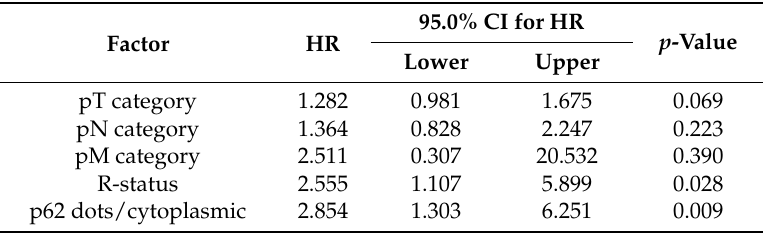
Table 1. Results of multivariate analysis including pT, pN, and M category. Table 2. Results of multivariate analysis including UICC/AJCC TNM stage. Factor Factor HR